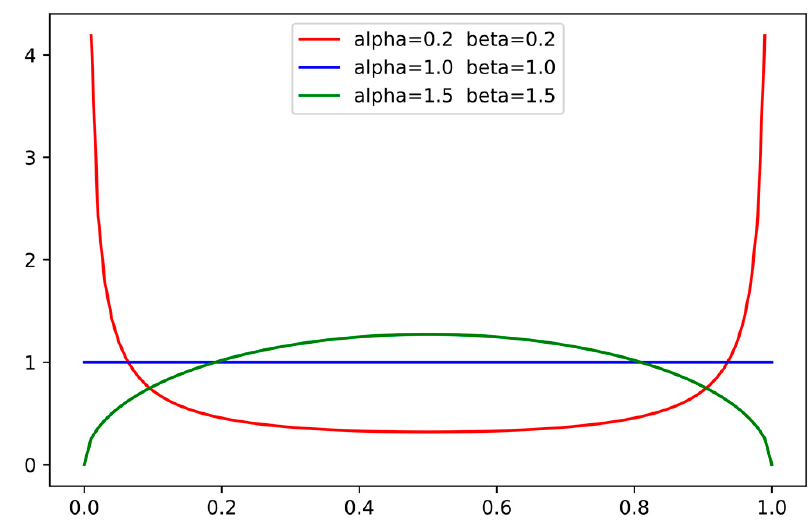
Figure 3. Probability density function of the Beta distribution for different values of parameters alpha and beta.